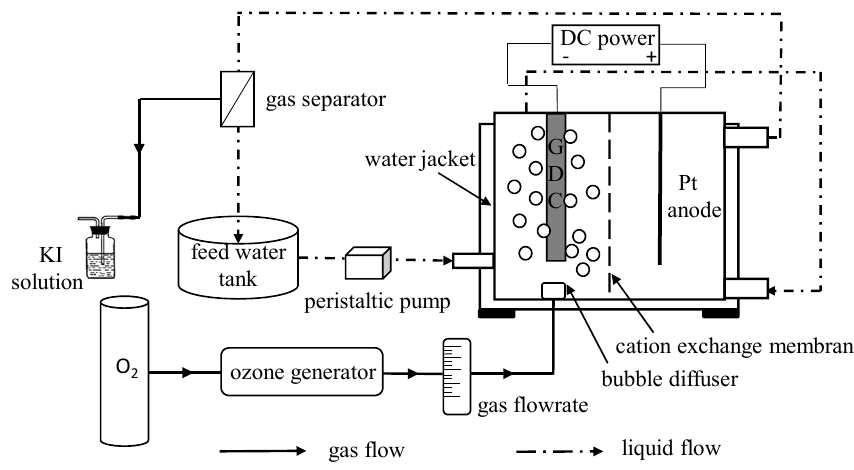
Figure 1. Schematic of experimental setup.